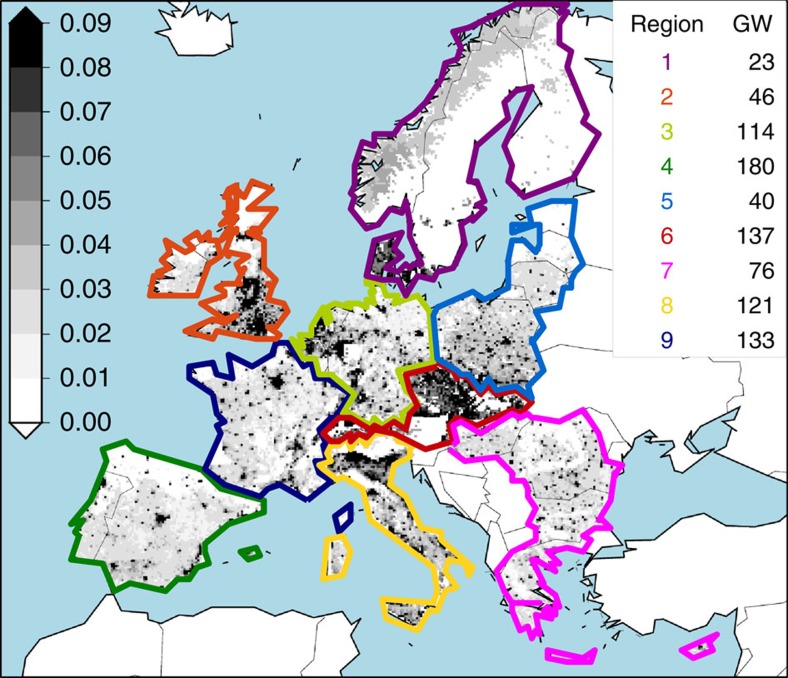
Estimated spatial distribution of the 2050 PV power fleet.In grey shadows: spatial density (in %) of the distribution of the PV power-installed capacity by the year 2050 as obtained with the CLIMIX model over the EURO-CORDEX spatial grid considering the regional targets proposed by the European Climate Foundation in its 80% RES pathway7. These targets are provided as GW of installed PV power capacity per region, as listed, with each region comprising either one or several countries, namely: Denmark, Finland, Norway and Sweden compose region 1; Ireland and UK, region 2; Belgium, Germany and The Netherlands, region 3; Portugal and Spain, region 4; Estonia, Latvia, Lithuania and Poland, region 5; Austria, Czech Republic, Slovakia, Slovenia and Switzerland, region 6; Bulgaria, Cyprus, Greece, Hungary and Romania, region 7; Italy and Malta, region 8; and France, region 9.